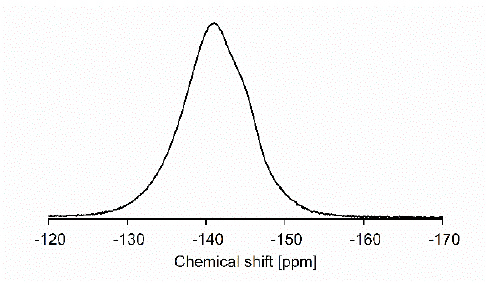
Figure 2. 19 F CP MAS NMR spectra of HHU-COF-2.